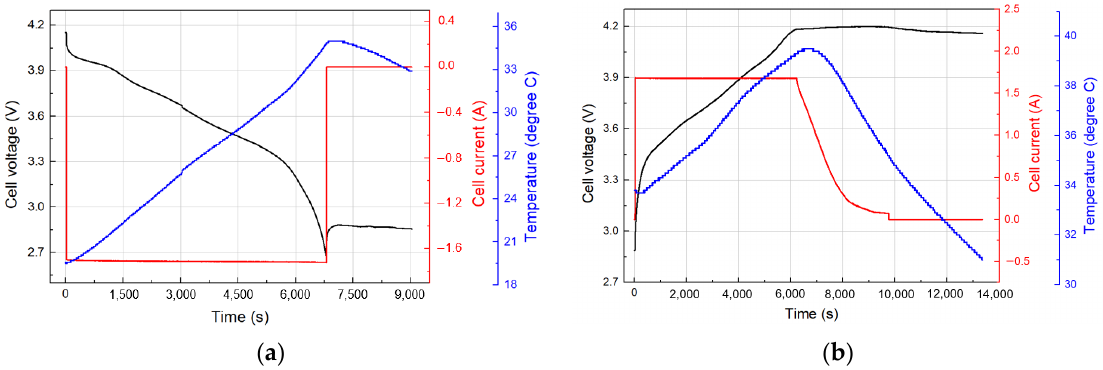
Figure 16. Experiment results for the battery pack characteristics: ( a ) discharge; and ( b ) charge.